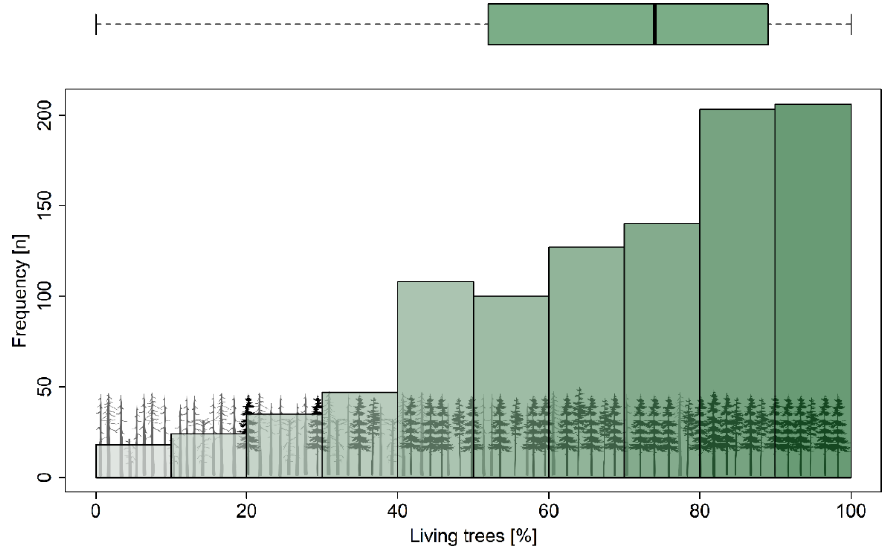
Figure 4. Frequency of respondents ( n = 1008) and the percentage of living trees, where respond- ents rated their personal well-being highest. The boxplot shows the median self-reported highest well-being (median = 0.74).